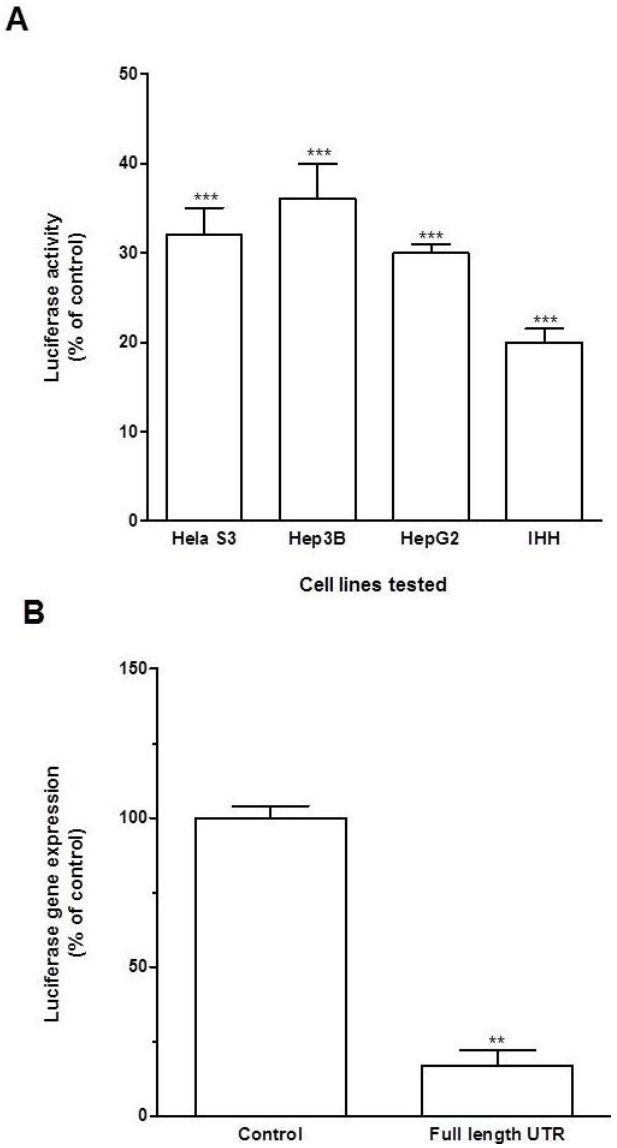
Figure 3. Effect of KLF6 UTR on gene expression. Hela, IHH, HepG2 and Hep3B cells were transfected for 48 h with plasmid containing KLF6 UTR. Control cells were transfected with psiCHECK2 plasmid. ( A ) Luciferase activity was determined as described in Experimental Section. Results are mean ± S.D. of three independent experiments.